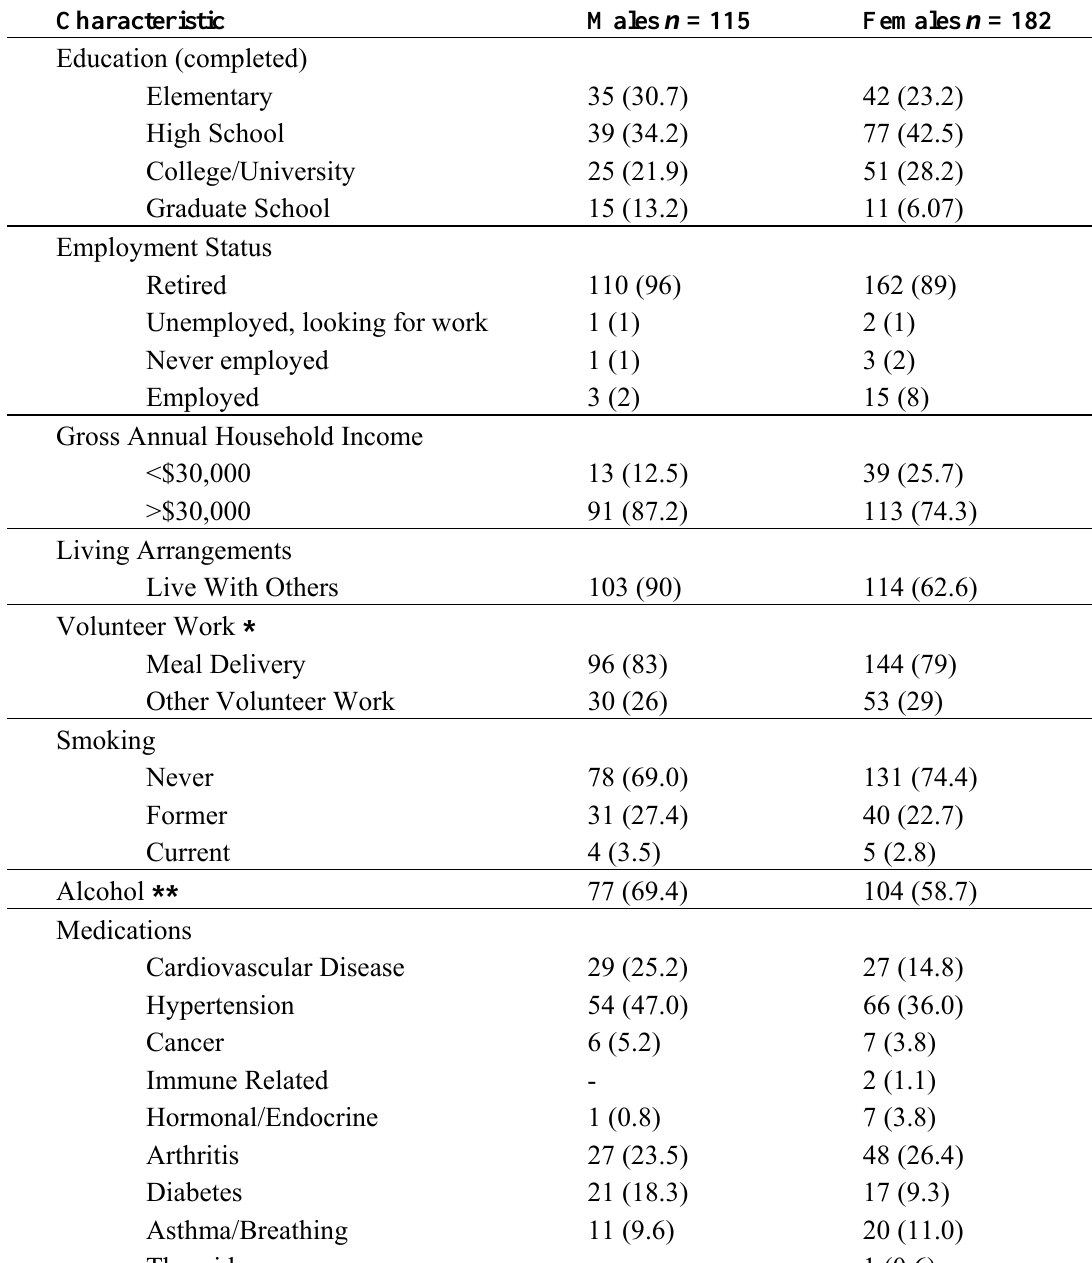
Table 1. Participant characteristics, stratified by